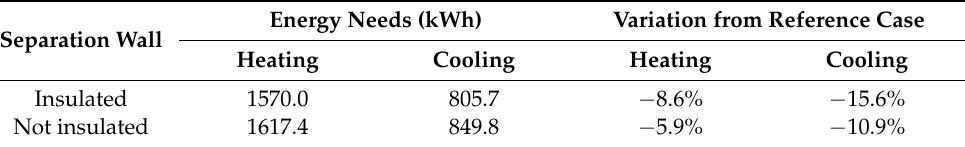
Table 11. Building’s annual energy needs and percentage change relative to the reference case for insulated and not insulated separation